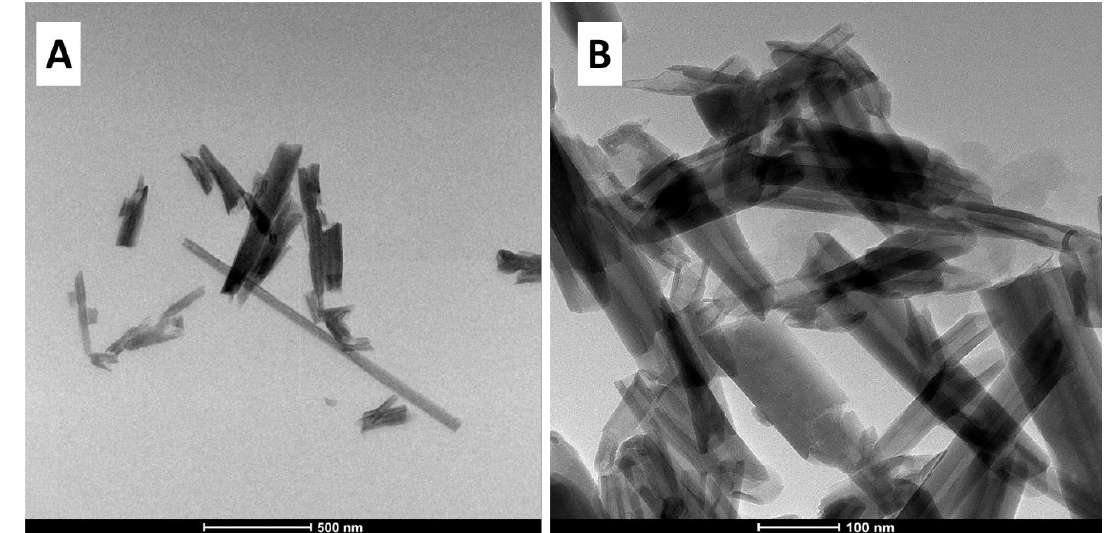
Figure 3. TEM images of ( A , B ) halloysite clay (HA) at different magnifications.